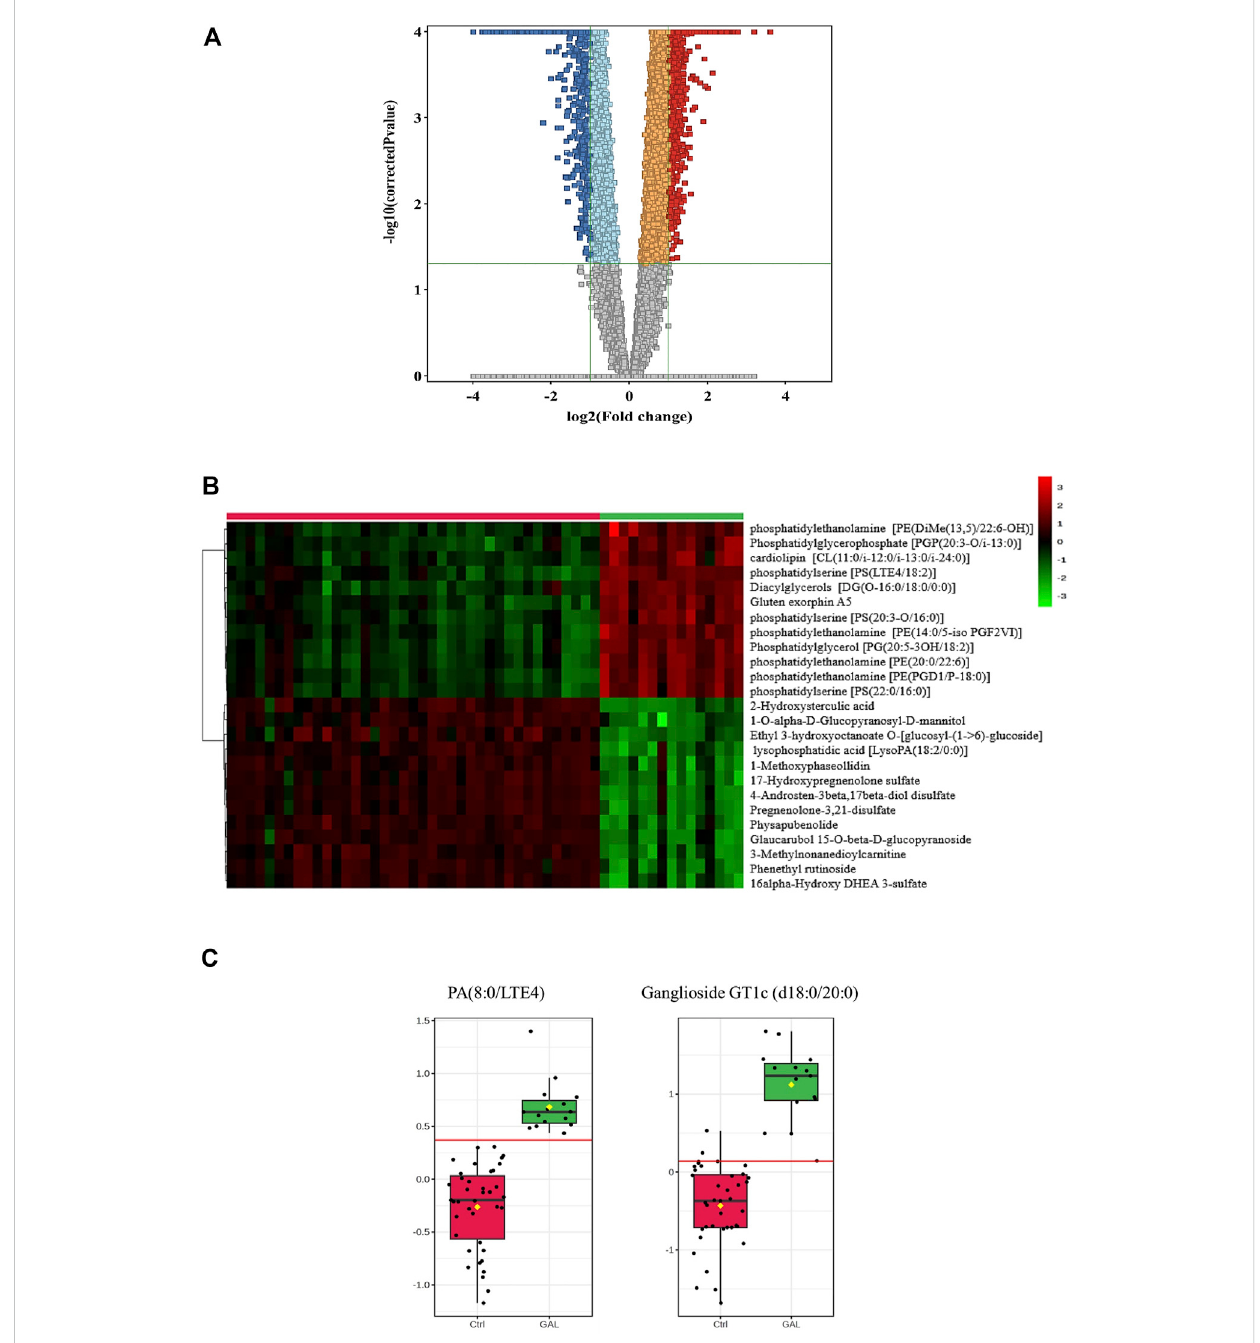
FIGURE 2 (A) VolcanoPlotdemonstratesthestatisticallysigni fi cantalteredmetabolites fi lteredbetweenthetwogroups(GALpatientsandhealthycontrol)that 2,819 signi fi cantly were dysregulated metabolites (FDR p -value ≤ 0.05, FC 2), of which 1,300 (red) and 1,519 (blue) metabolites were up-and downregulatedinGALpatientscomparedtohealthycontrol,respectively.Redandbluerefertoup-anddownregulatedmetabolites,respectively.Orange and light blue squares refer to metabolites that failed to pass fold change cutoffs and were up- and downregulated, respectively. Gray square metabolites failed to pass both cutoffs. (B) Heat map representing the top 25 signi fi cantly ( p < 0.05) altered metabolites between the two study groups; healthy control (red) and GAL patients (green). (C) Boxplots for a couple of metabolites [Ganglioside GT1c (d18:0/20:0) and PA (8:0/LTE4)] where green represents GAL patients and red represents